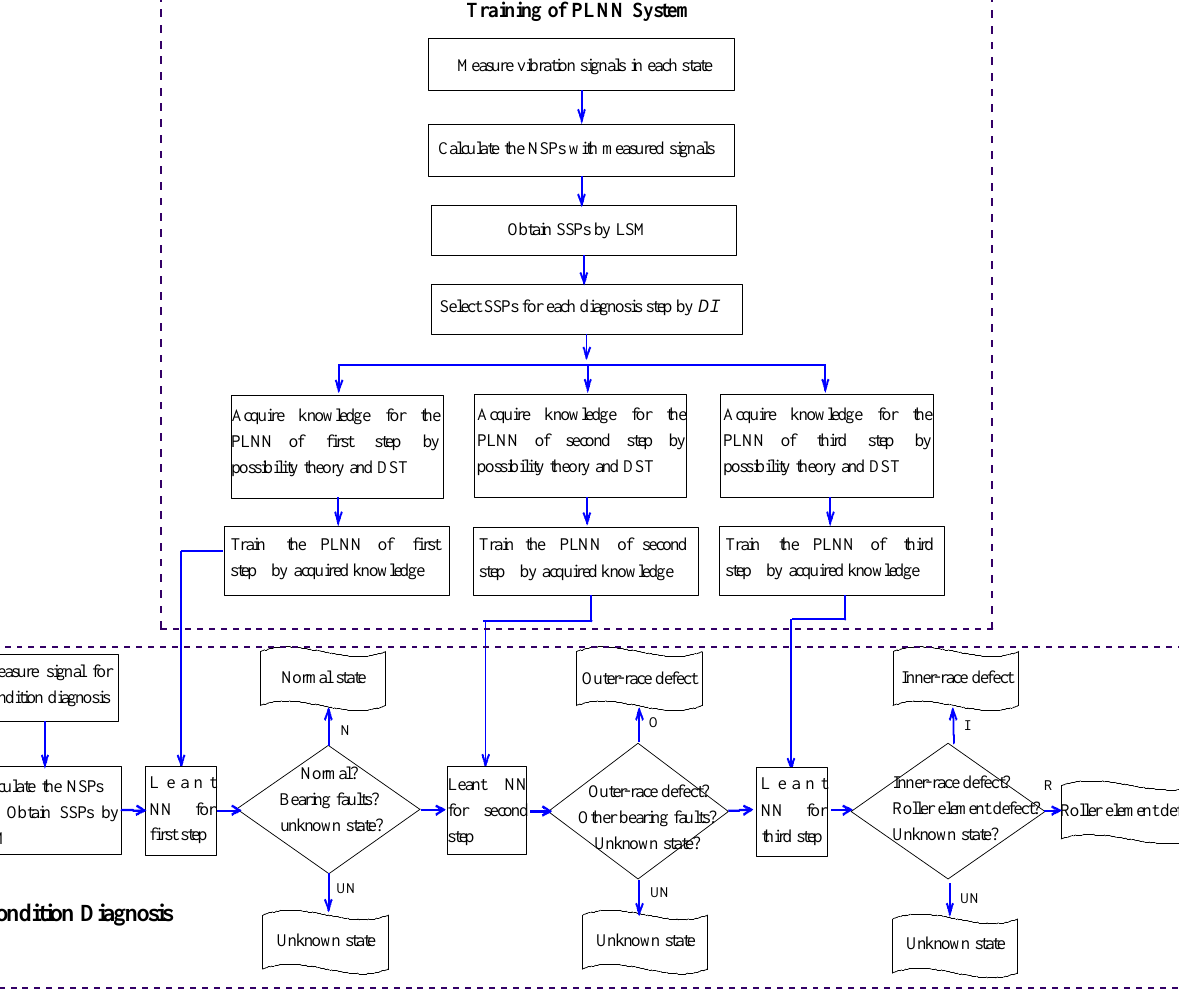
Figure 6. Flowchart of sequential condition diagnosis.